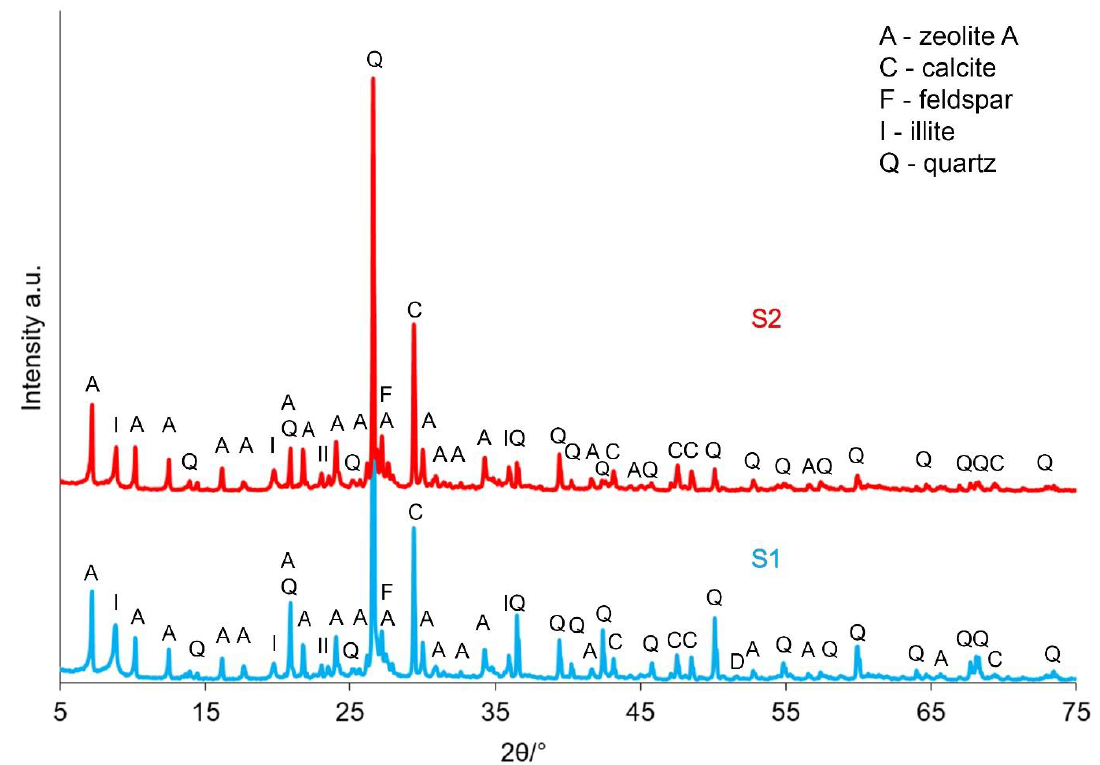
Figure 7. XRD patterns of samples depending on the sampling point: S1 and S2.